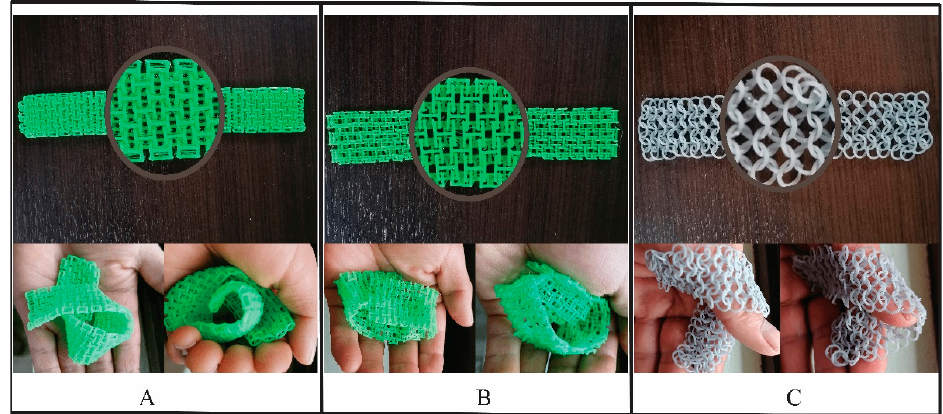
Figure 13 . Visual, tactile and comfort inspection analysis. ( A ) cylindrical elements; ( B ) prismatic elements; and ( C ) annular elements.